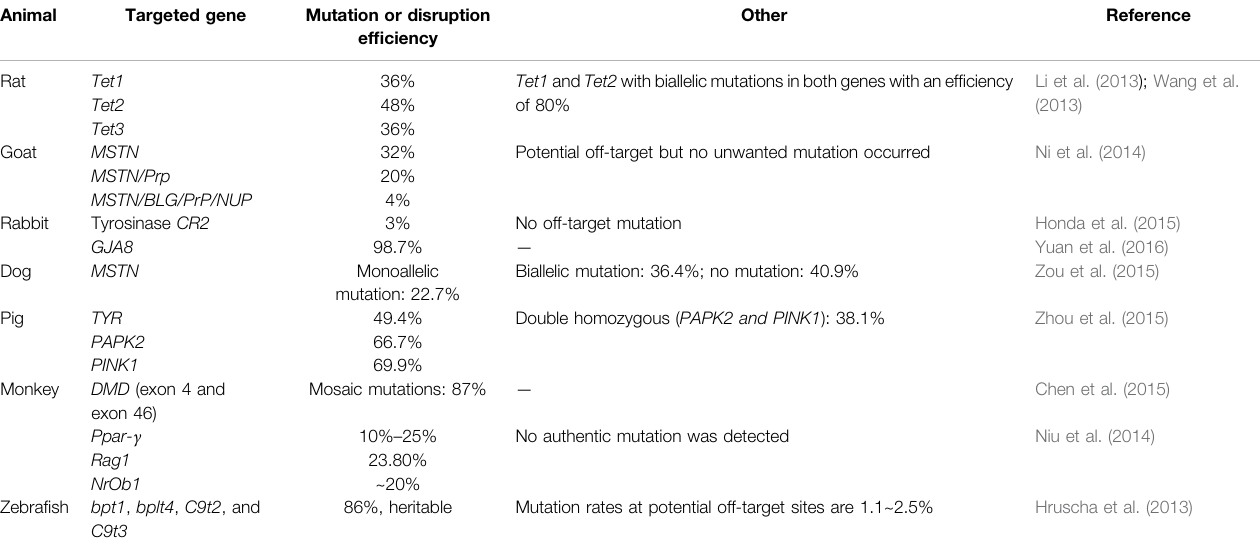
TABLE 1 | CRISPR/Cas9 gene editing in animals. Animal Targeted